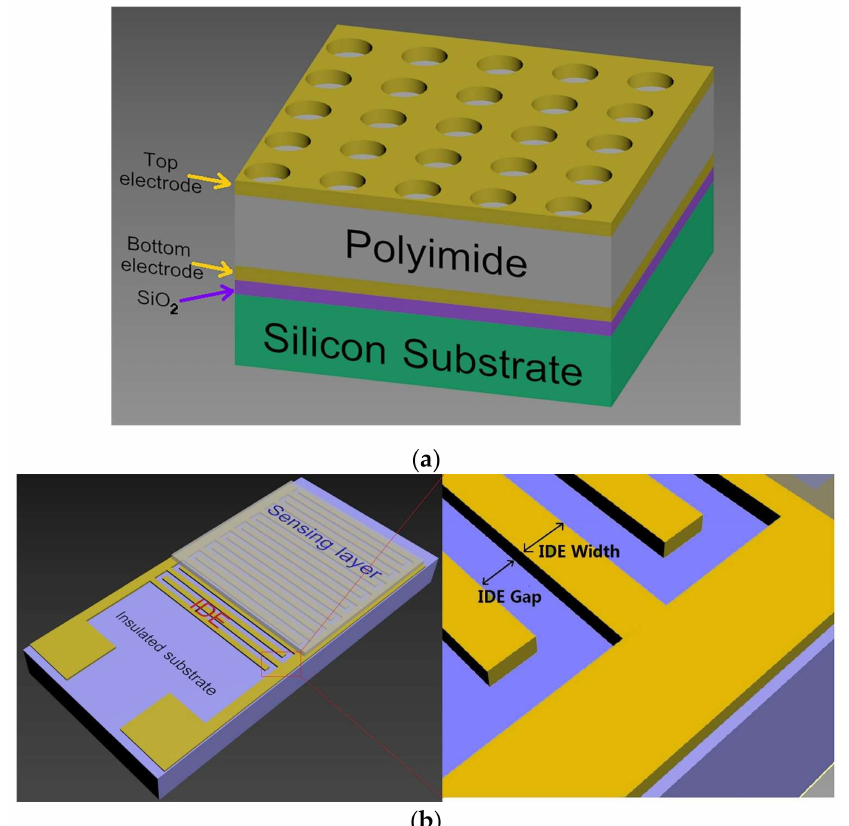
Figure 1. Structure diagram of parallel plate (PP) and interdigital electrode (IDE) sensors. ( a ) PP sensors composed of a solid substrate, two layers of parallel plate electrode, and a sensing material between them. ( b ) IDE sensors composed of an inert substrate, IDEs, and sensing material layer atop of the IDEs. A partial enlarged detail of IDE is shown on the